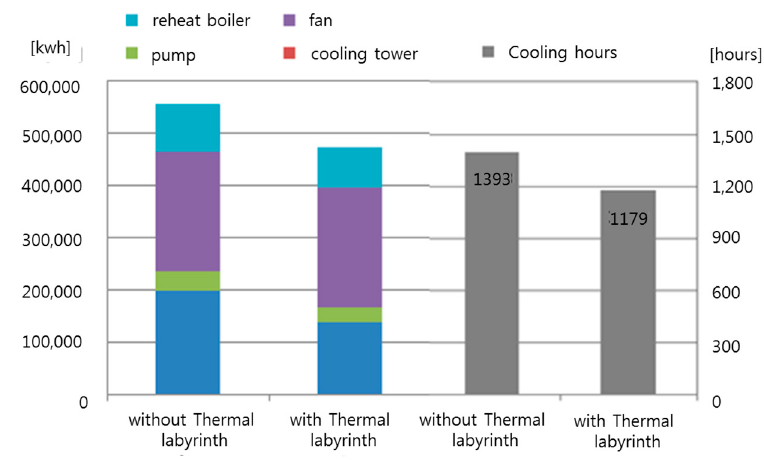
Figure 18. Cooling energy consumption and cooling hours. Table 11. Energy saving ratio for air conditioning.